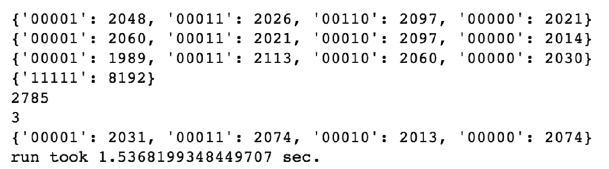
Figure 5. Final state measurement counts for five groups of four data entries, each searched by GA. The fourth group contains the target lepton index = 3, and its corresponding state was measured all 8192 times on the simulator